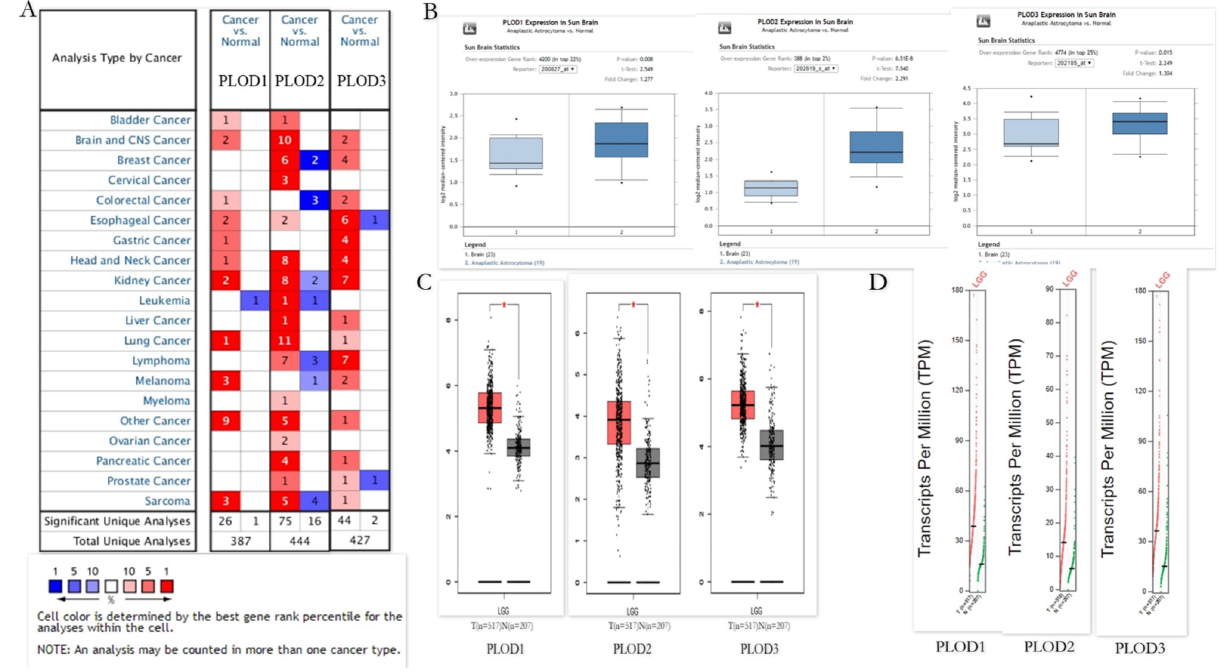
Fig 1. The expression of PLOD family members in different tissues. (A) The transcription levels of PLOD family members in different types of cancers Red, upregulation; blue, downregulation. The number in each cell indicates the datasets that met the set threshold in each cancer type. Cell color was defined as the gene rank percentile for analyses within the cell. (B) Expression levels of PLODs family members compared between subtypes of LGG and normal tissues from the Oncomine. (C) Boxplot results of the expression levels of PLODs family members in LGG analyzed using GEPIA. Red box, tumor samples; green box, normal samples. T, tumor; N, normal. (D) Expression profile of PLODs family members in LGG analyzed using GEPIA. Red trace, tumor samples; green trace, normal samples.